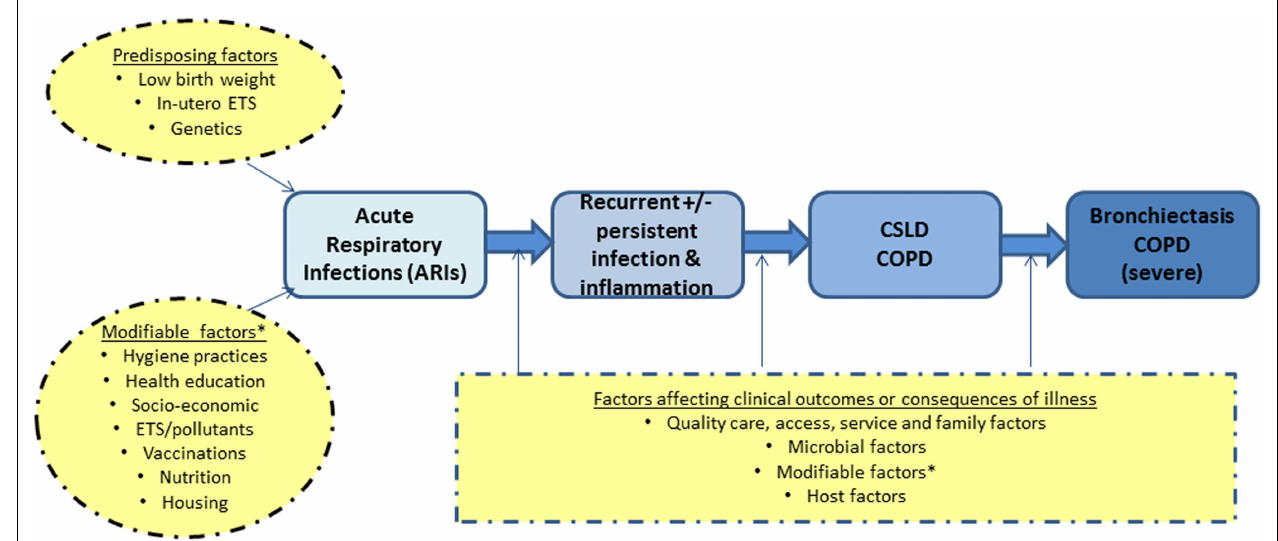
FIGURE 1 |A simplified diagram on the development of severe lung disease in adulthood (blue) and the possible factors (yellow) that likely influence the progression of disease . COPD, chronic obstructive pulmonary disease; CSLD, chronic suppurative lung disease; ETS, environmental tobacco smoke